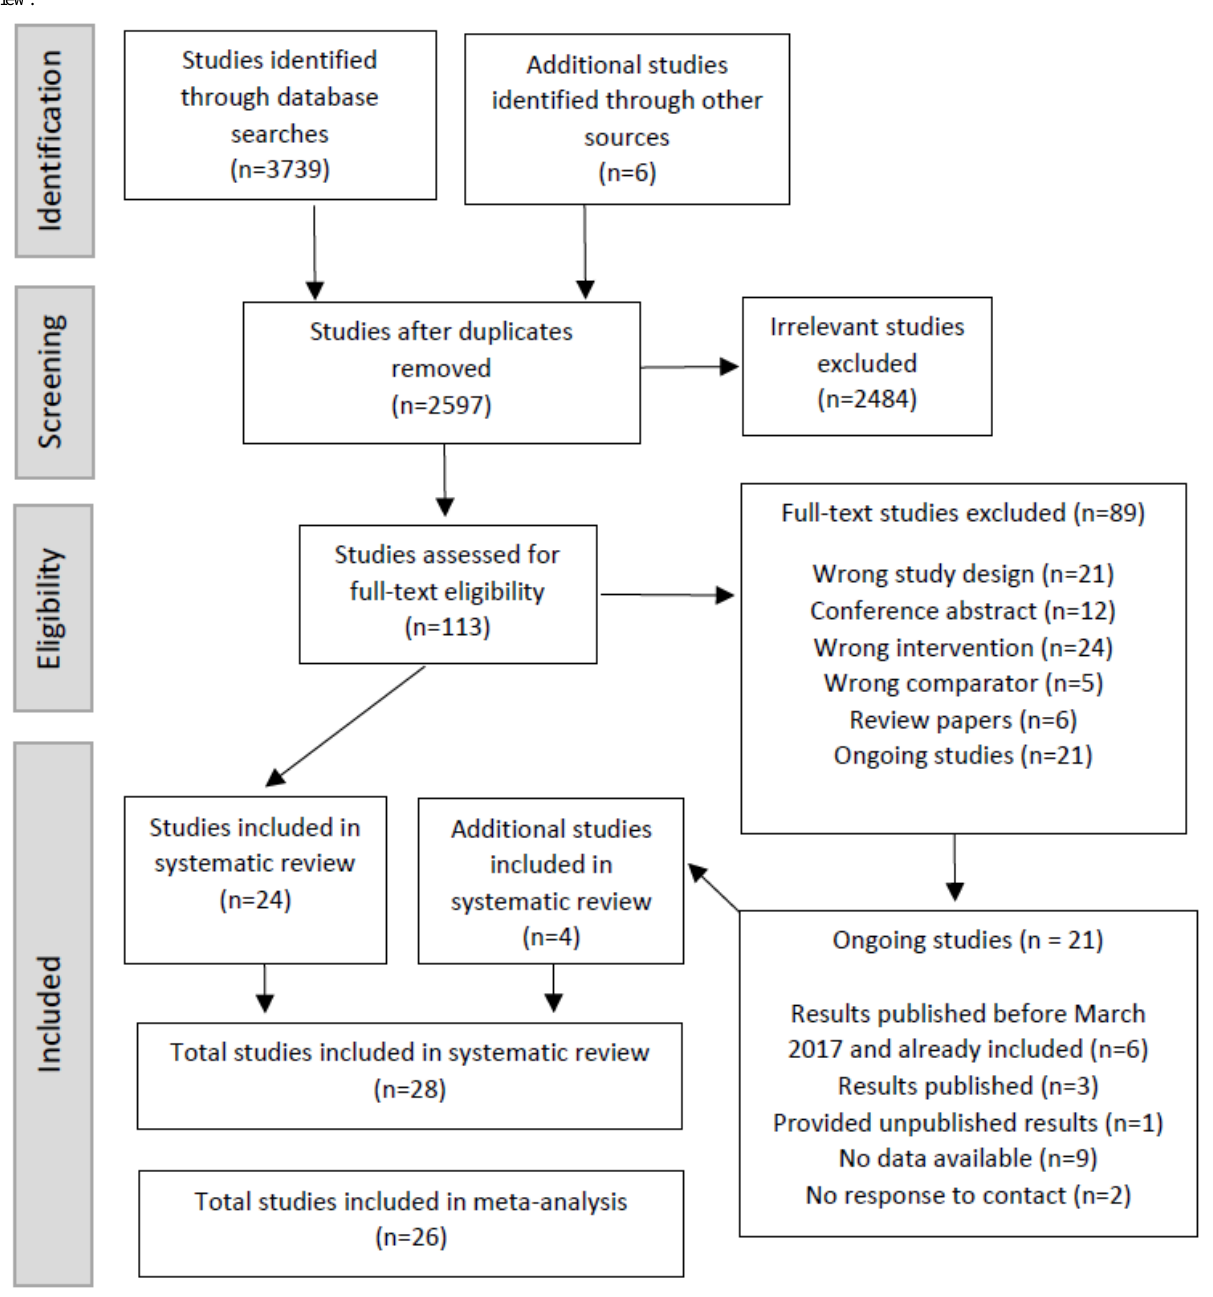
Figure 1. Flowchart of study selection. Studies with results published and authors that provided unpublished results were included in the systematic